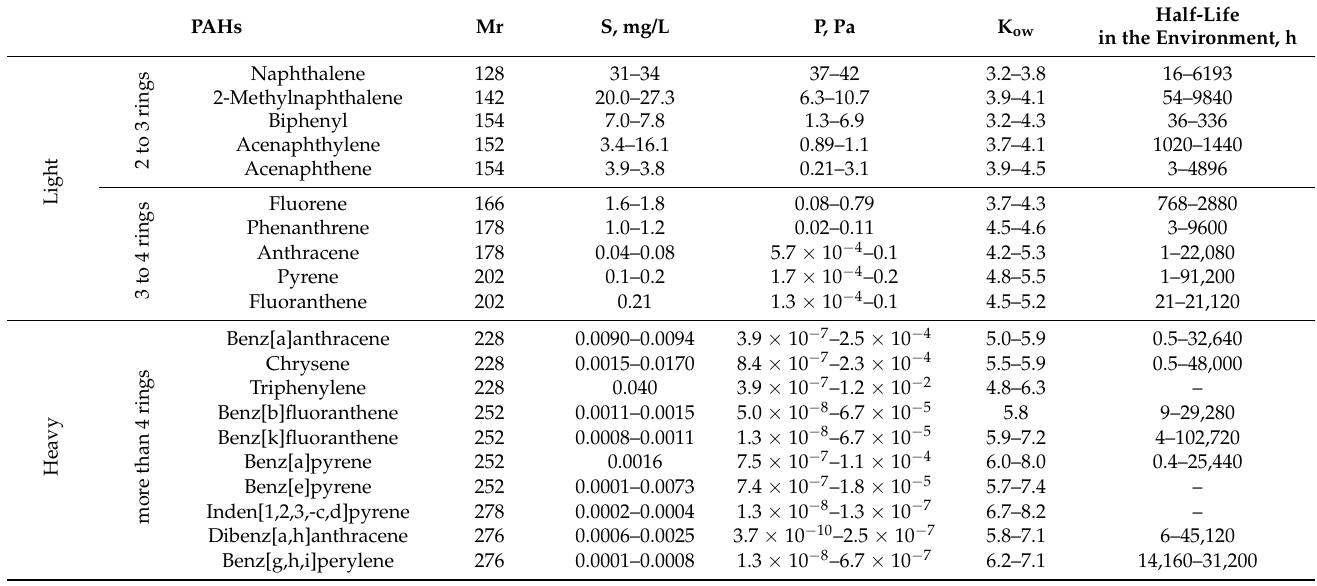
Table 1. Some physicochemical properties of polycyclic aromatic